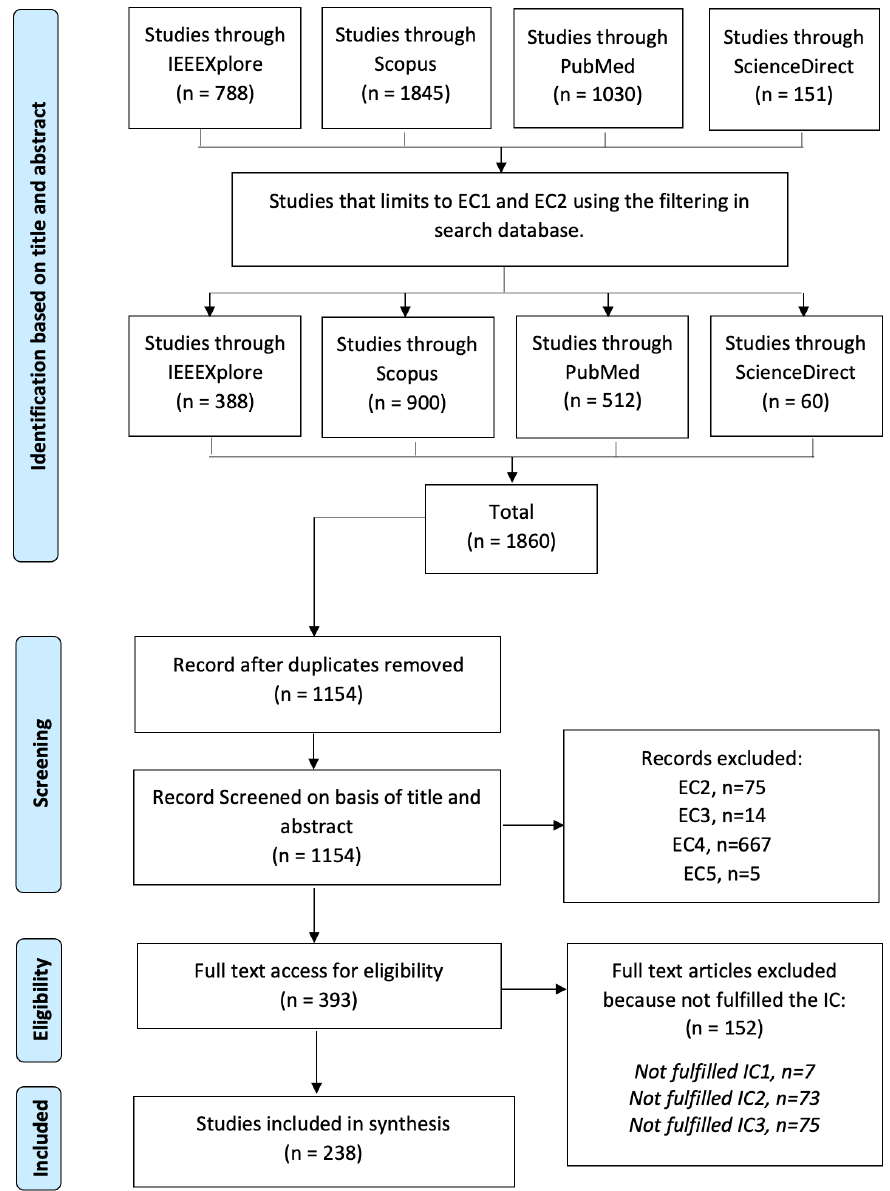
Figure 3. Flow process using the PRISMA